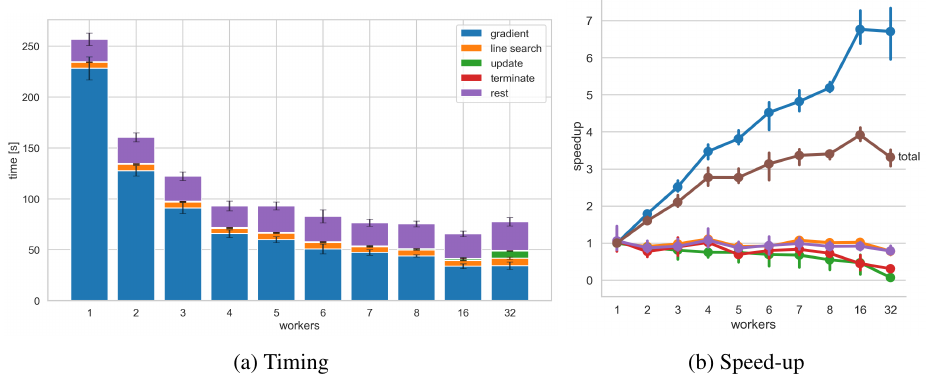
Figure 3: Big model benchmark results. In this run, for each number of workers, the fit was repeated only 3 times and we additionally measured the line-search phase separately. See the caption of figure 1 for further